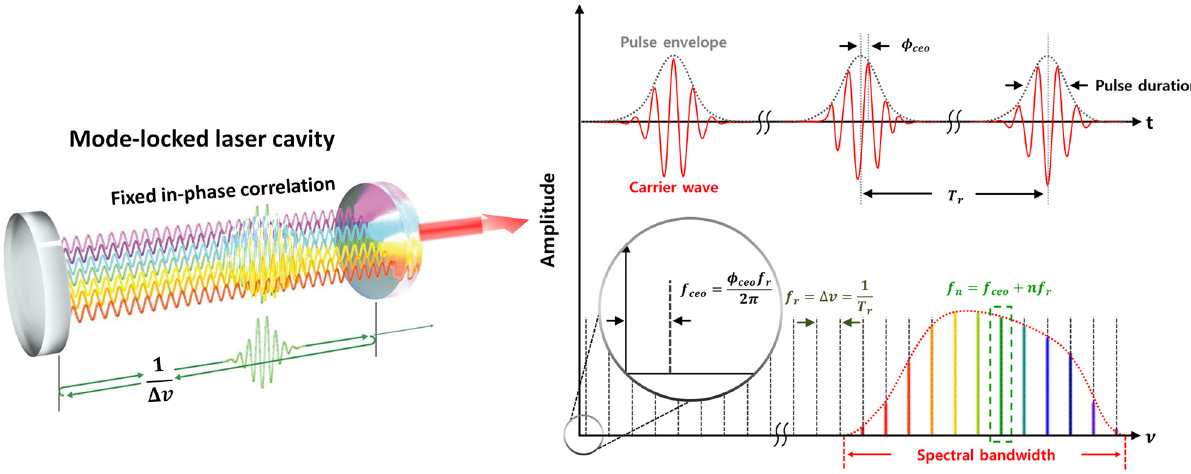
Figure 3: Characteristics of mode-locked ultrafast lasers in the time and frequency domains. Each intracavity mode is expressed as f n = f ceo + nf r in the frequency domain, which provides a broadband frequency comb while adding to form an ultrashort pulse train in the time domainwithaperiod T r ,whichistheinverseoftherepetitionrate f r .Theslightlydifferentphasesofeachcarrierwavegeneratethe f ceo shown as f ceo = ϕ ceo f r [215]. 2 π